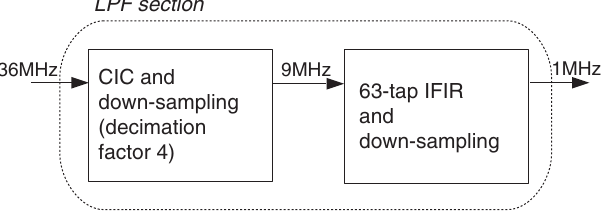
FIG. 8. LPF composed of a series of CIC and FIR. FIG. 11. (Color) RFG